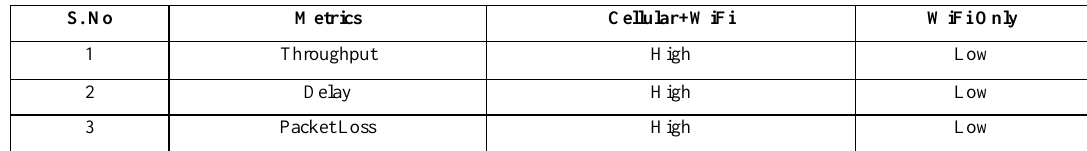
Table 2. Simulation